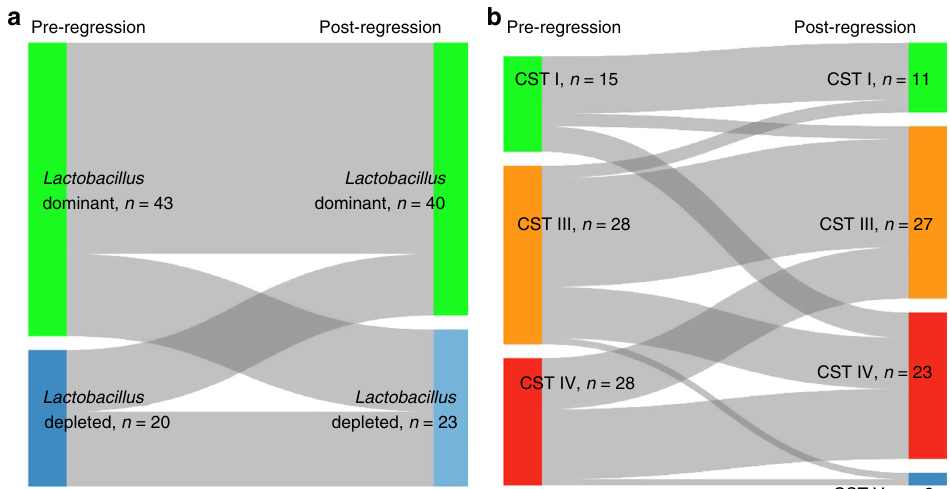
Fig. 7 Sankey diagram of VMB composition immediately pre- and post-regression. There was no signi fi cant difference in vaginal microbiota composition at either genus ( a ) or species level ( b ) in the sample immediately before, and the sample immediately after regression, n = 63. CST Community state type, CST I Lactobacillus crispatus -dominant, CST III Lactobacillus iners -dominant, CST IV Lactobacillus spp.-depleted, high diversity.